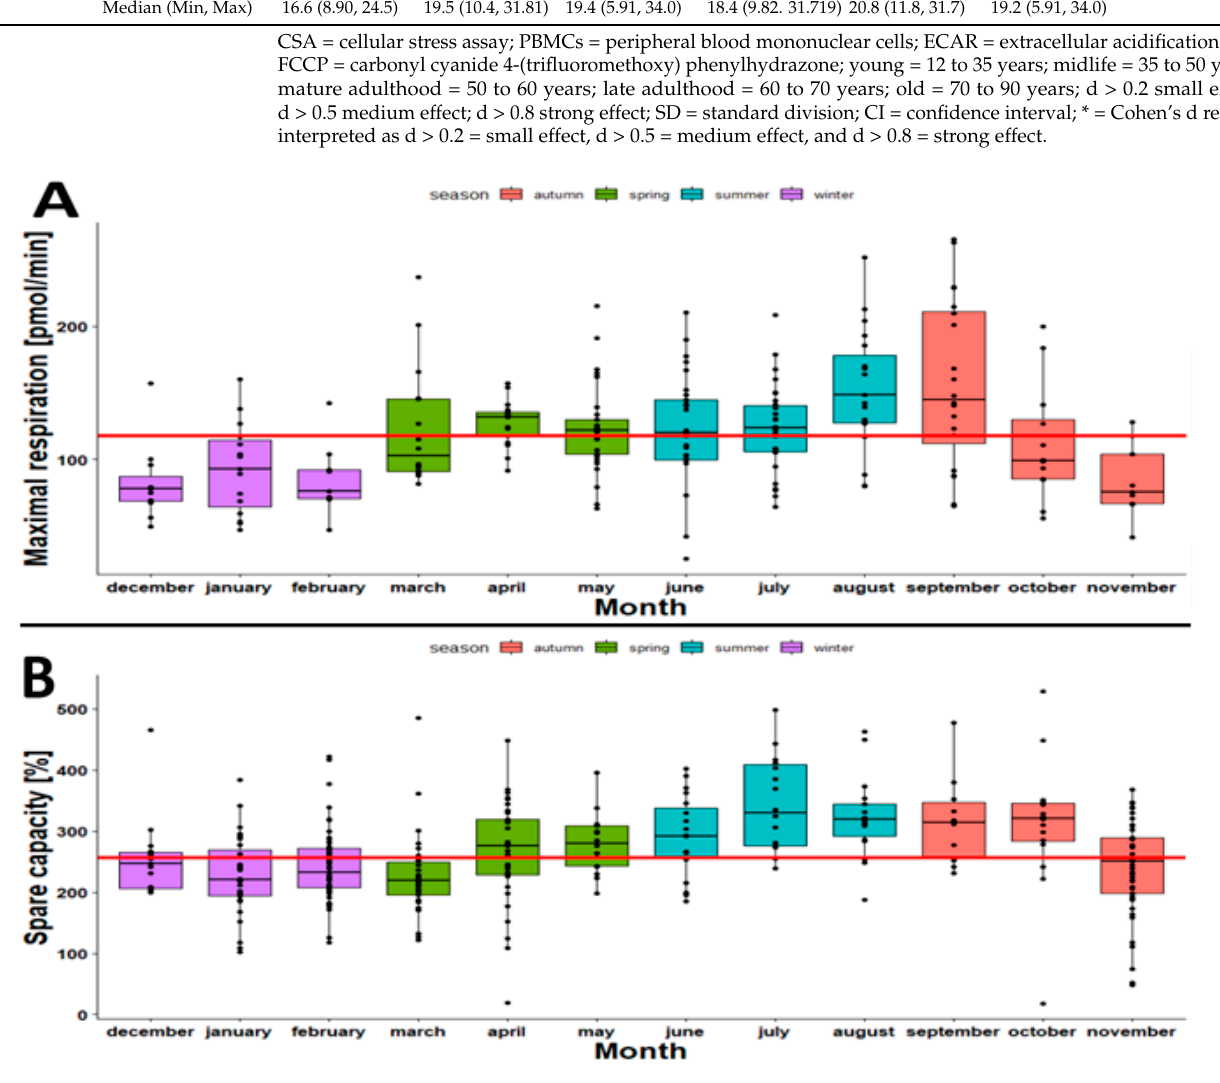
Figure 7. ( A ) Boxplots of maximal respiration (pmol/min) of Robo-isolated PBMCs by month. Sample size ( n ): January = 17, February = 7, March = 16, April = 17, May = 29, June = 29, July =